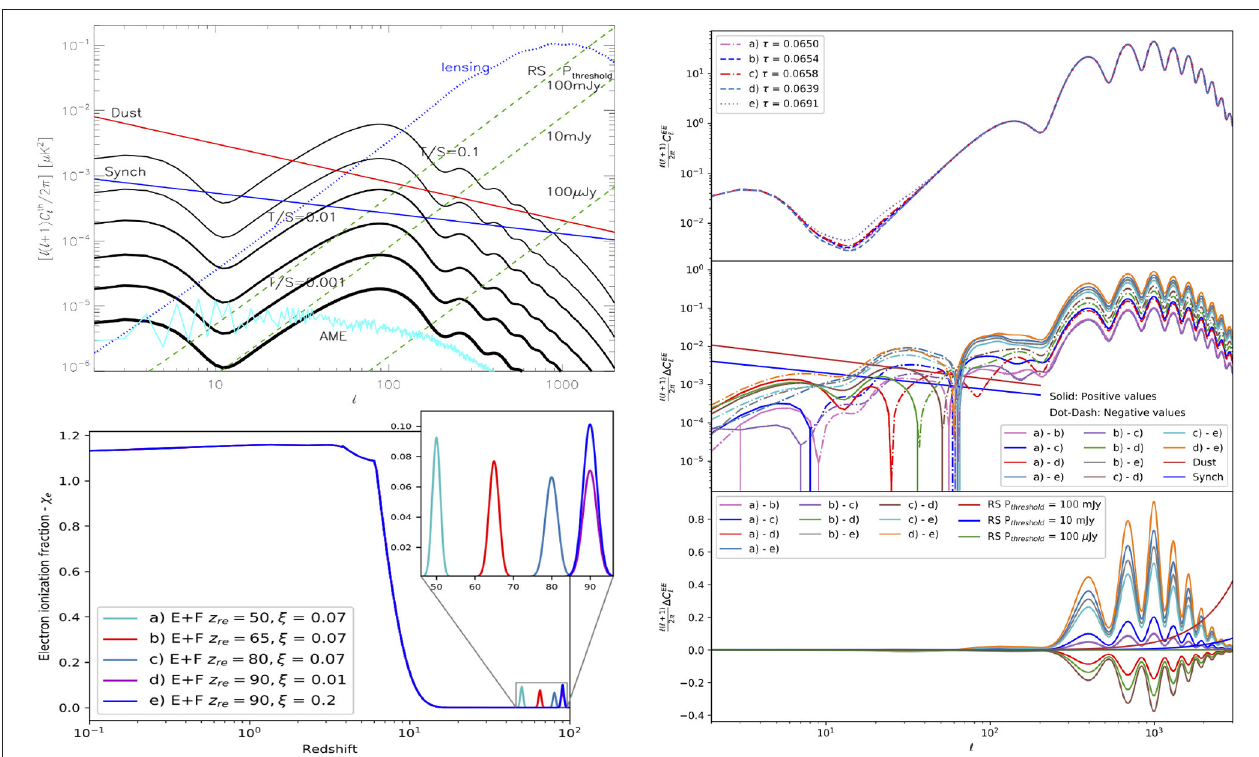
FIGURE 7 | Top-Left : CMB primordial B -mode polarization APS for different tensor-to-scalar perturbation ratios (from 1 to 3 × 10 − 4 ; solid black lines), lensing B -mode APS (blue dots), estimates of potential residuals of Galactic foregrounds (at 70 GHz) in B -mode polarization APS, and APS from polarized radio sources (at 100 GHz) below different detection thresholds in polarized flux density (green dashes; from top to bottom, 100 mJy and 10 mJy, representative of thresholds achievable, respectively, in current and future CMB experiments, and 100 µ Jy representative of potential improvement achievable with SKA). Red curve shows typical potential residuals from Galactic polarized dust emission APS extrapolated from 353 GHz assuming an error of 0.01 in the dust grain spectral index. Blue curve shows typical potential residuals from Galactic polarized synchrotron emission APS extrapolated from 30 GHz assuming an error of 0.02 in the synchrotron emission spectral index. Cyan curve shows an estimate of AME APS scaled from total intensity to polarization with a polarization degree of 2% and assuming equal power in E - and B -modes. Bottom-Left : Evolution of the electron ionization fraction for five models assuming a phenomenological early phase of reionization peaked at a redshift z = z re and for various values of the parameter ξ (defining the amplitude of the ionizing photons production coefficient ε i ) followed by the filtering model (E+F) resulting into slightly different values of τ (see right panel). Right : CMB E -mode polarization APS (in µ K 2 units) computed for the reionization models shown in the bottom-left panel ( Top ), their differences compared to potential residual of Galactic dust and synchrotron polarized emissions as in top-left panel but for the E -mode ( Middle ), and their differences ( Bottom ) compared to APS from polarized radio sources as in top-left panel but in linear scale to make high multipoles more evident. All data and methods used for producing this figure have been published. The CMB B -mode polarization APS have been computed using the CAMB code ( Lewis et al., 2000). The methods described in Trombetti and Burigana (2012) have been used to compute the CMB E -mode polarization APS. The CMB lensing B -mode polarization APS is based on Planck Collaboration (2016b). Potential residuals of Galactic foreground emissions are based on Planck Collaboration (2016a,c) and on the ESA Planck Legacy Archive. The E - and B -mode APS of radio sources are modeled according to Trombetti et al. (in press). See also the legends and the